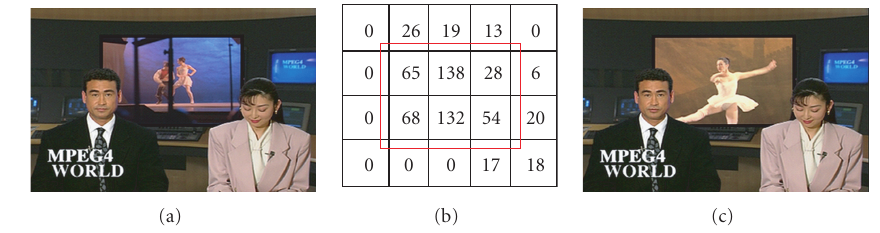
Figure 6: Local frame dynamics evidenced by virtual frame partition.